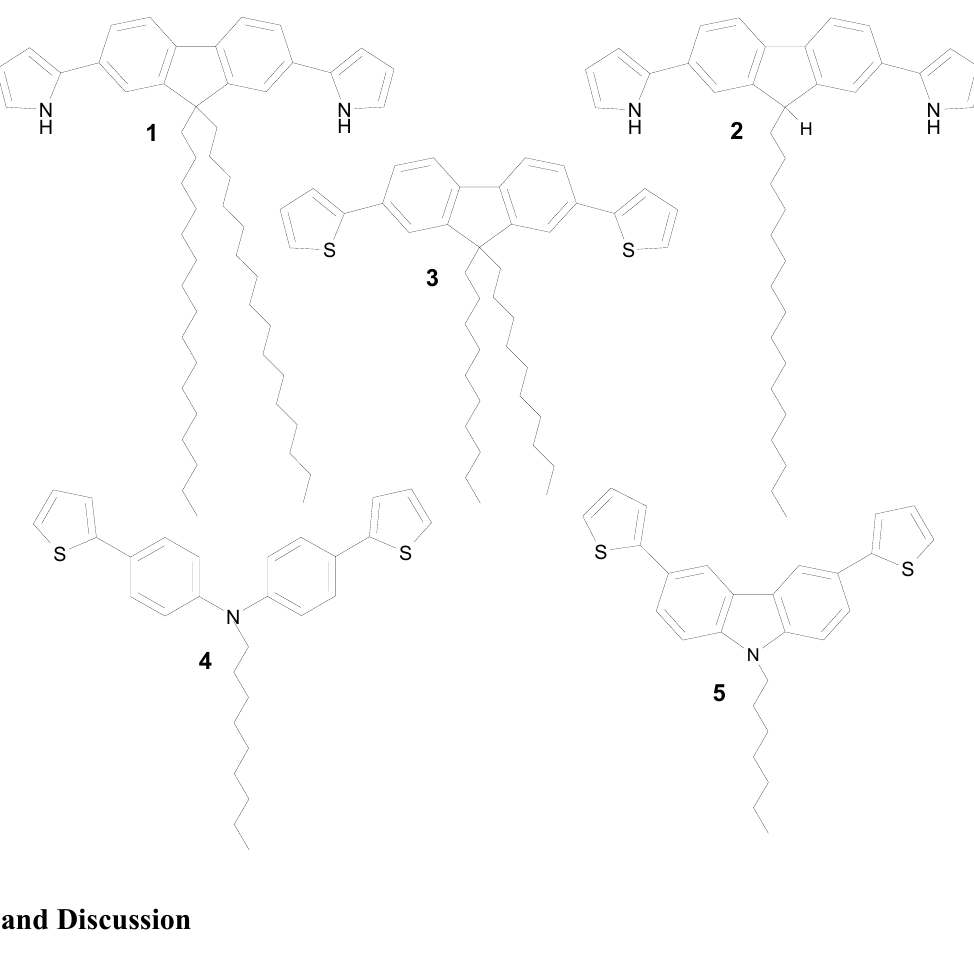
Figure 1. Some conducting structures used as chemical sensor elements: 9,9-dihexadecyl- 2,7-bis(pyrrole-2-yl)fluorene ( 1 ), 9-hexadecyl-2,7-bis(pyrrole-2-yl)fluorene ( 2 ), 9,9-didecyl- 2,7-bis(2-thiophene)fluorene ( 3 ), N -nonyl-4,4’-bis-(thiophene)diphenylamine ( 4 ), N -heptyl- 3,6-bis(2-thiophene)carbazole ( 5 ).